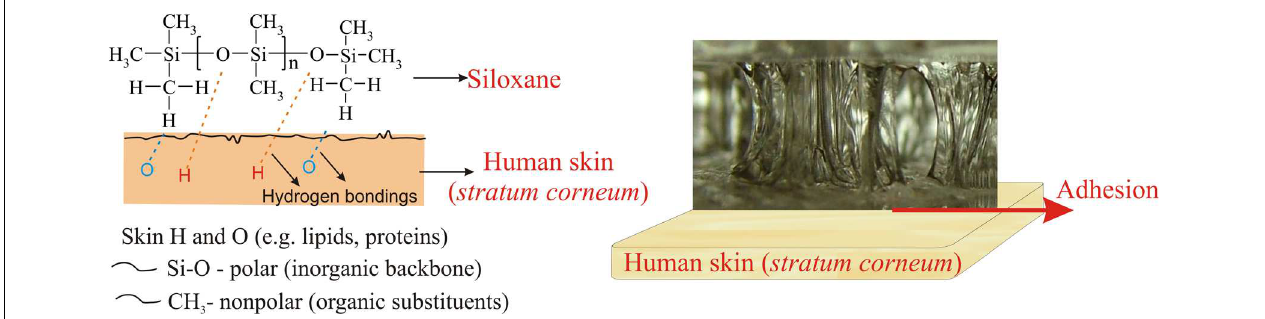
FIGURE 5 | Ability to form hydrogen bonds with human skin as a result of the amphiphilic nature of siloxanes and adhesion of silicone elastomer to the skin.